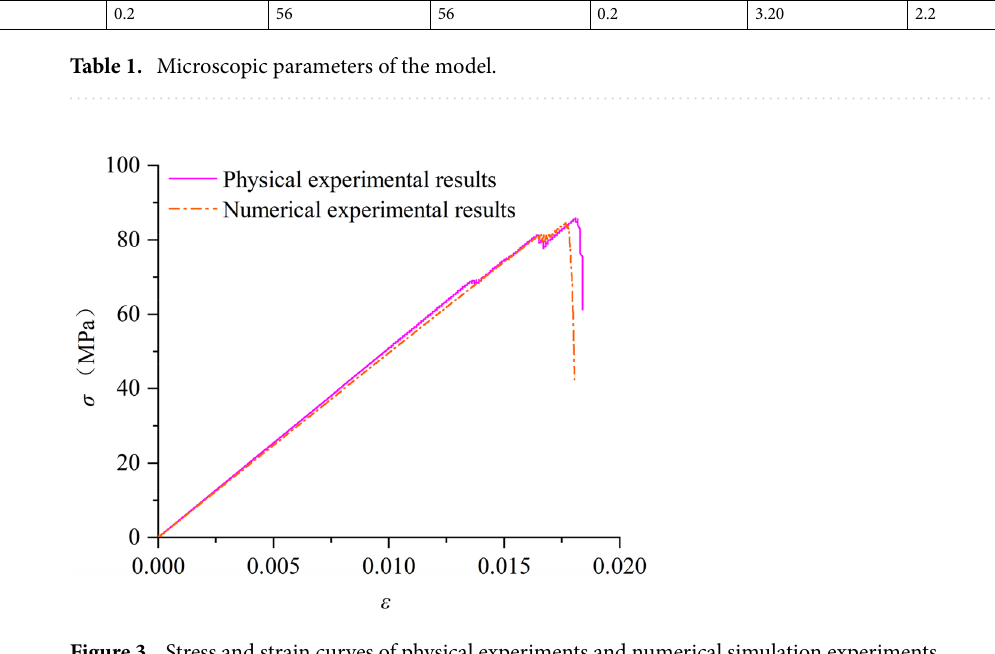
Figure 3. Stress and strain curves of physical experiments and numerical simulation experiments.